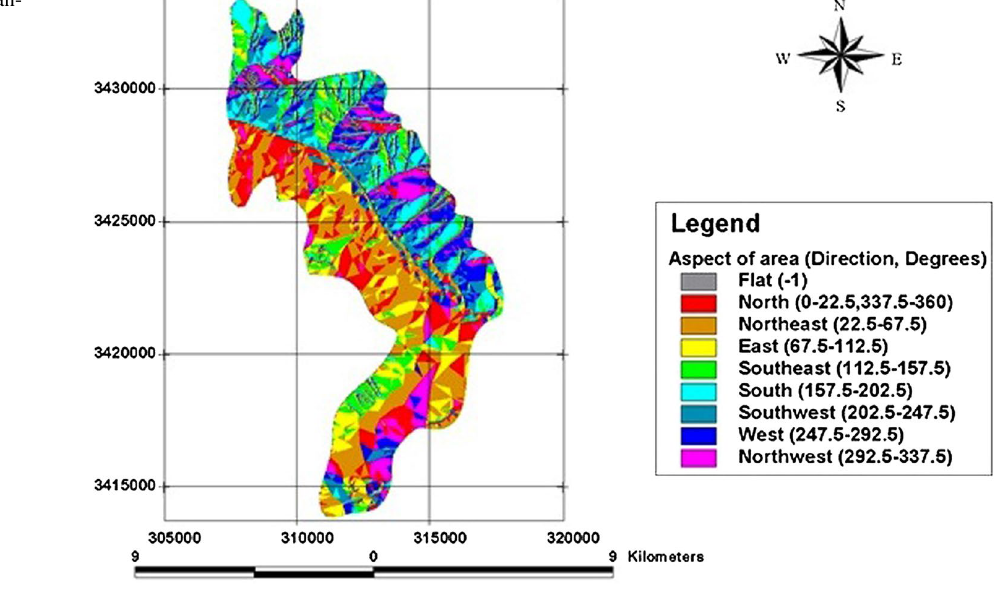
Fig. 6 Aspect map of the Gan- gotri glacier area